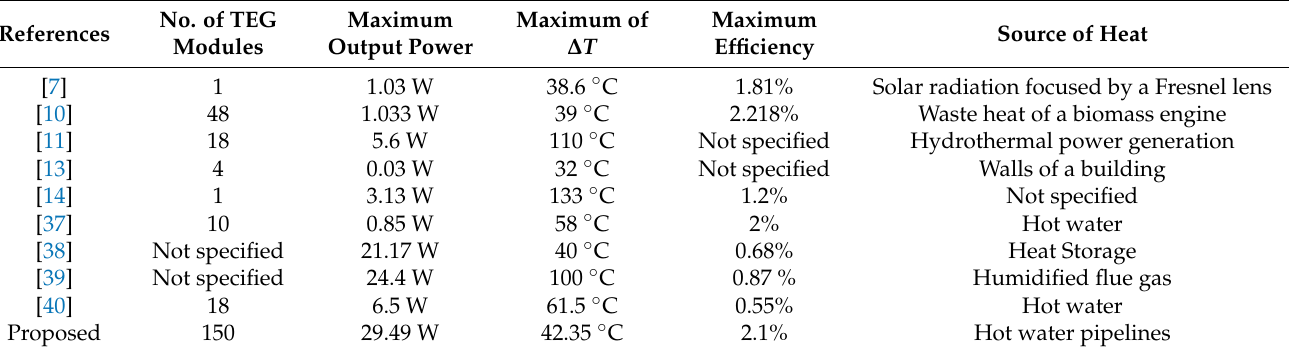
Table 2. Comparative analysis with earlier